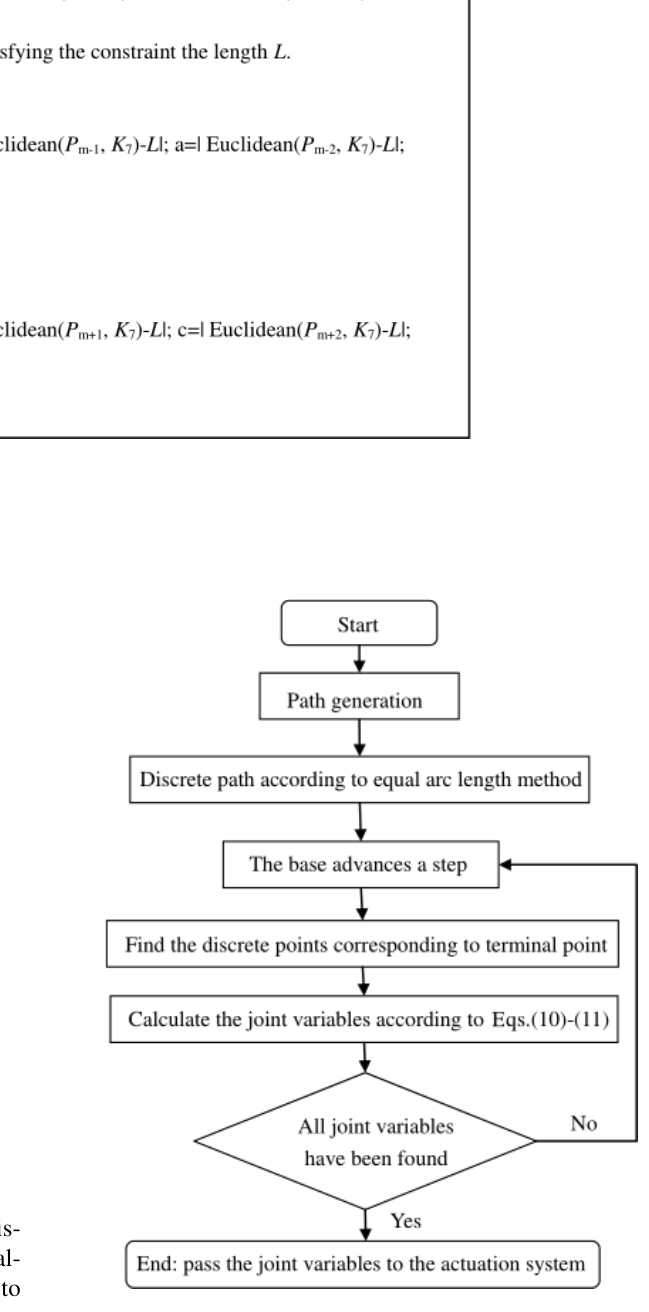
Figure 10. Flowchart of the tip-following